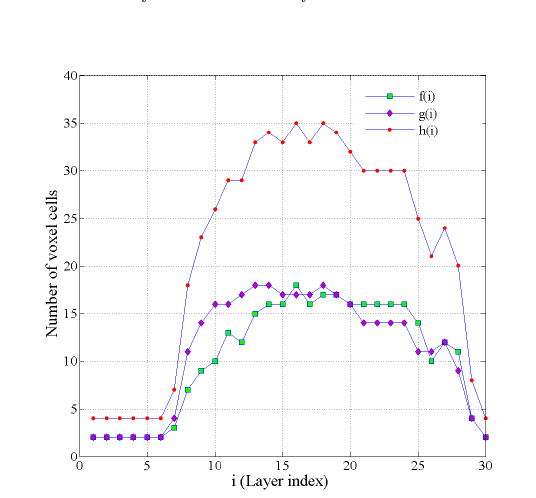
Figure 5: Estimating the DBH of a